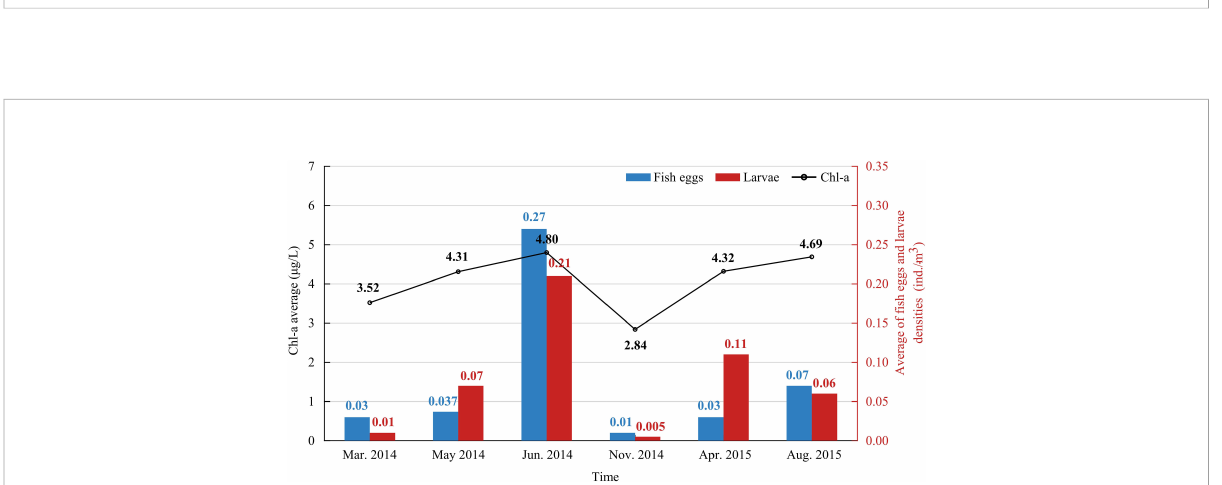
FIGURE 9 Temporal correlation between the biomass density of fi sh eggs and larvae and Chl- a concentration in the water of the Zhoushan